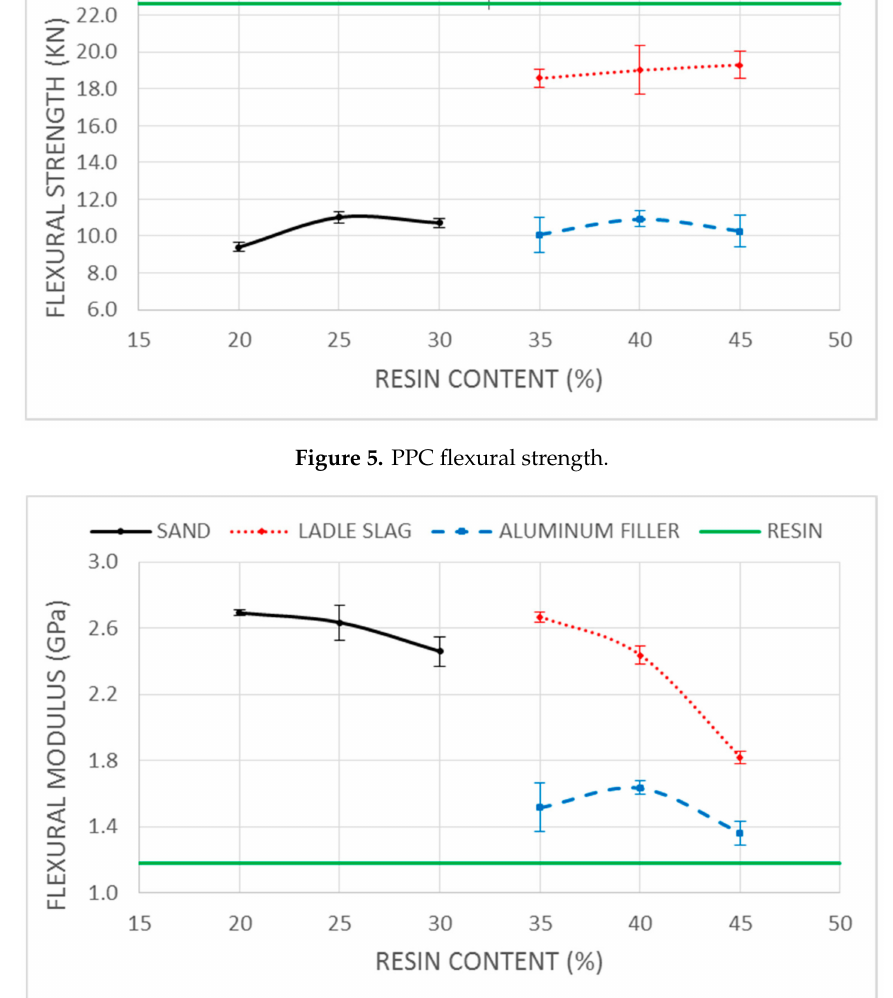
Figure 6. PPC flexural elasticity